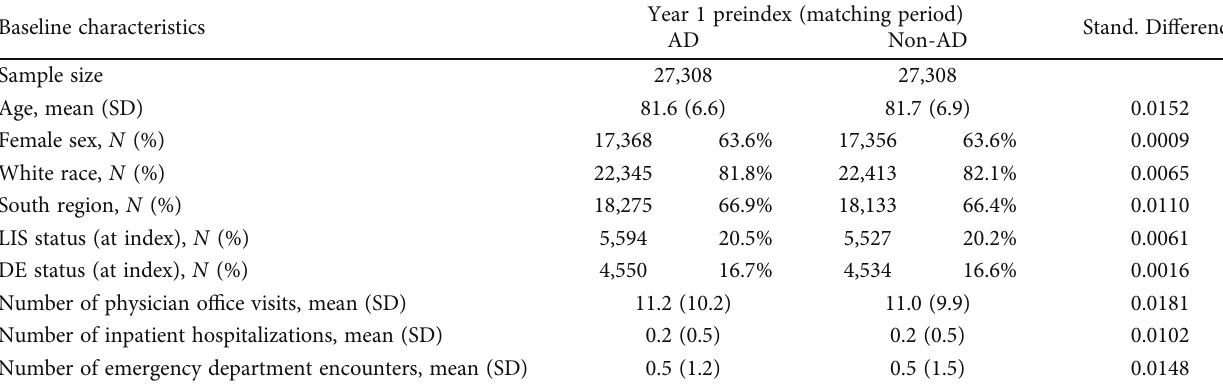
Table 1: Baseline demographics and clinical characteristics, matched AD dementia and non-AD cohorts. Baseline